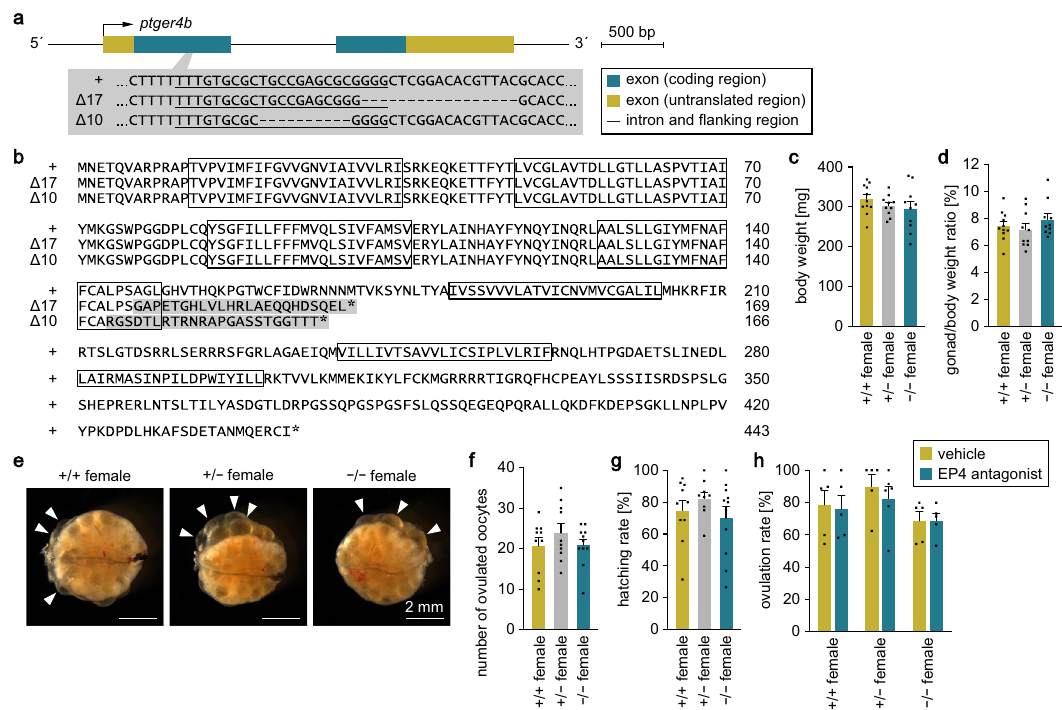
Fig. 4 ptger4b -de fi cient females retain normal ovarian development and function. Two independent lines of ptger4b knockout medaka ( Δ 17 and Δ 10) were generated by CRISPR/Cas9-mediated genome editing. a The gene structure of ptger4b is shown with the location of the CRISPR target site, which is enlarged to depict the nucleotide sequences of the wild-type ( + ) and targeted ( Δ 17 and Δ 10) alleles. The target sequence complementary to the CRISPR RNA is underlined, and deleted nucleotides are indicated by dashes. b Comparison of the deduced Ptger4b protein sequences of the + , Δ 17, and Δ 10 alleles. Boxes represent the predicted transmembrane domains of Ptger4b. The altered sequence caused by frameshift is shaded in gray. Asterisks indicate stop codons. Body weights ( c ) and gonad/body weight ratios ( d ) of adult ptger4b + / + ( n = 11), ptger4b + / − ( n = 10), and ptger4b − / − ( n = 10) females of the Δ 17 line. e Representative images of the ovaries of adult ptger4b + / + , ptger4b + / − , and ptger4b − / − females of the Δ 17 line. Arrowheads indicate representative ovulated oocytes. Scale bars represent 2 mm. Number of ovulated oocytes ( f ) and hatching rate of fertilized eggs ( g ) of ptger4b + / + ( n = 10), ptger4b + / − ( n = 10), and ptger4b − / − ( n = 11) females of the Δ 17 line. h Effect of the EP4 antagonist GW 627368X on the ovulation of oocytes from ptger4b + / + , ptger4b + / − , and ptger4b − / − females in vitro ( n = 5 for each experimental group except ptger4b + / − females treated with the EP4 antagonist, where n = 6; each n comprises 8 – 20 oocytes). Quantitative data were expressed as means with error bars representing standard error of